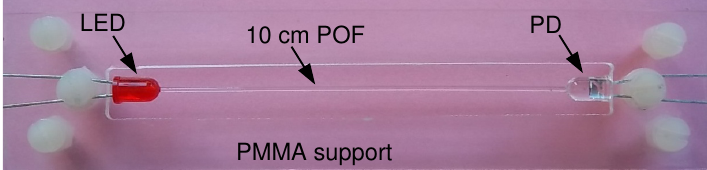
Figure 4. Sensor assembly composed of fiber, LED and